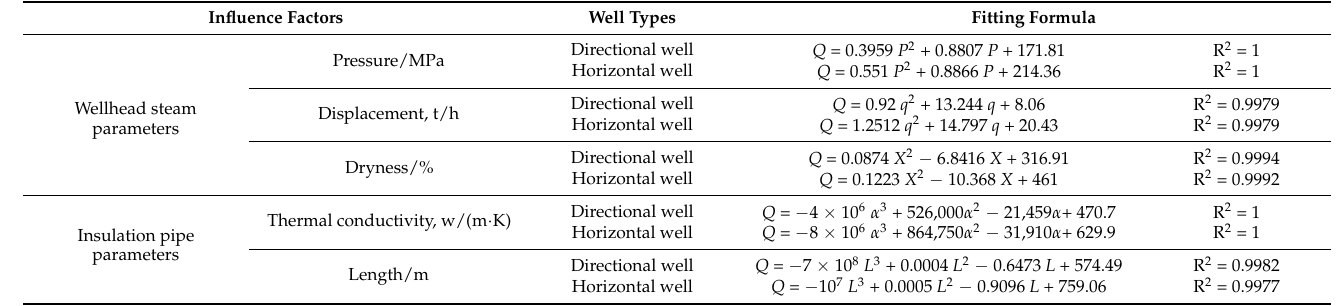
Table 2. Impact model of different influencing factors on critical nitrogen injection rate